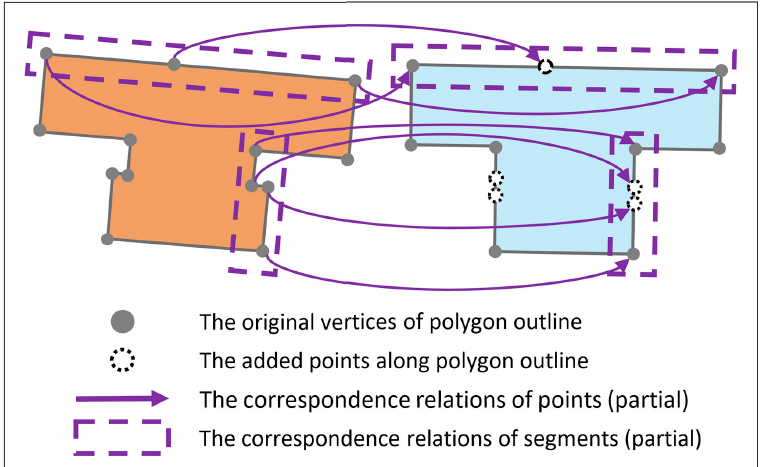
Figure 4. Illustration of the correspondence relation of segments and control points.